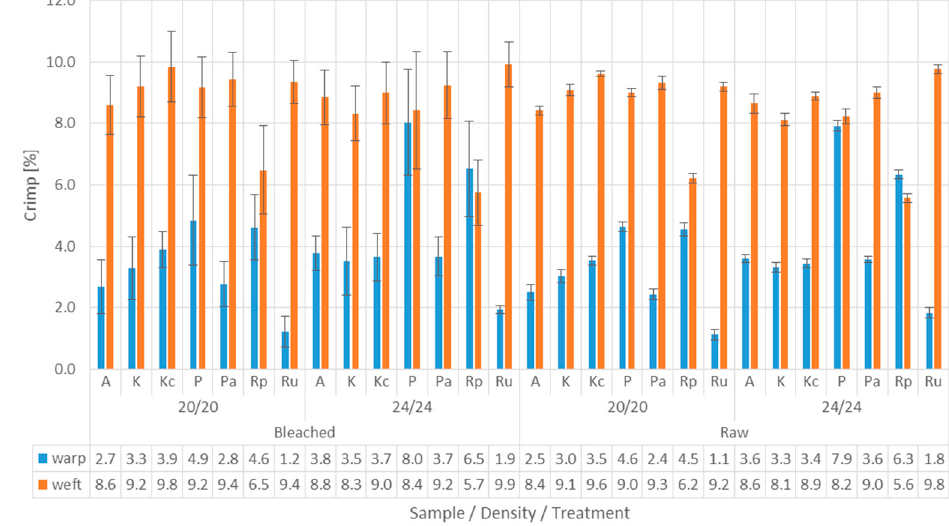
Figure 5. Warp and weft crimp in fabric samples.